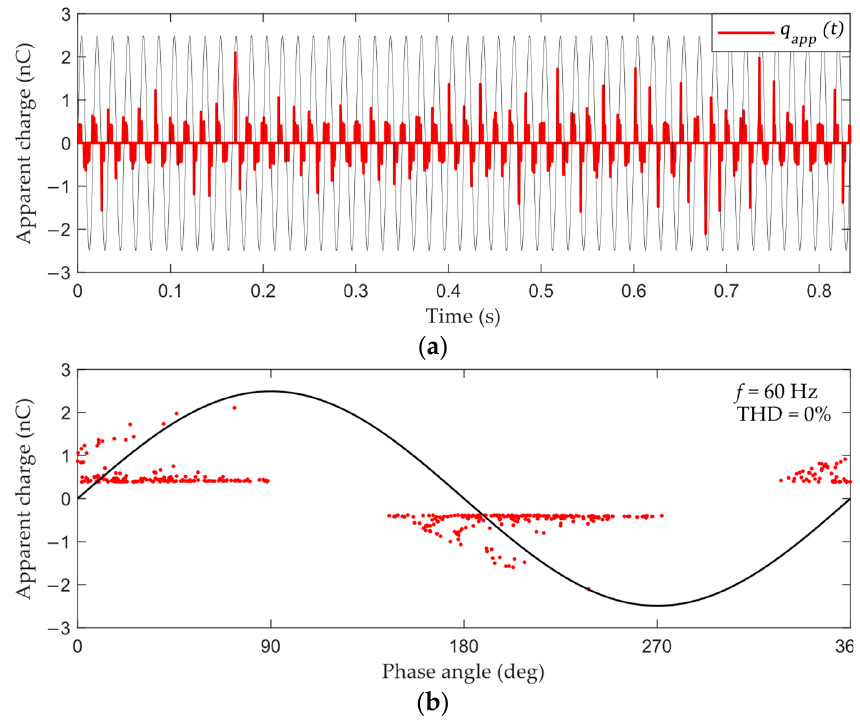
Figure 9. Results of the first simulation wherein a purely sinusoidal voltage was applied: ( a ) apparent charges generated by the PDs over time; ( b ) PRPD pattern obtained.